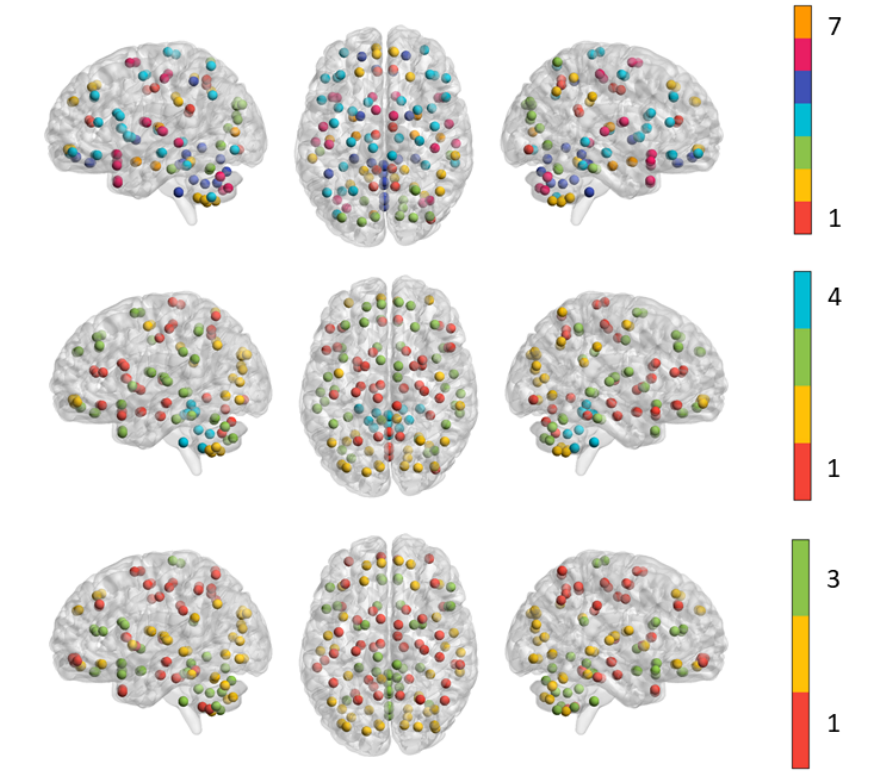
Figure 6. The functional modules detected in SYNC networks ( top panel), Pearson correlation network ( middle panel) and coherence network ( bottom panel). All the ROIs within the same module are indicated with spheres of the same